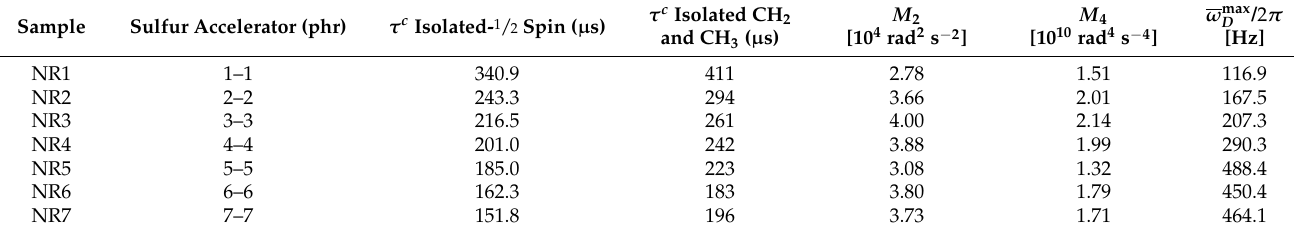
Table 1. The values for the correction time τ c obtained as a result of correction procedure of the DQ Fourier spectra based on spin- 1 / 2 and isolated CH 2 and CH 3 approximations for the series of cross-link density from NR1 to NR7. The second M 2 and fourth M 4 residual van Vleck moments and the maximum of the DQ Fourier spectra obtained for the last approximation. Sample Sulfur Accelerator